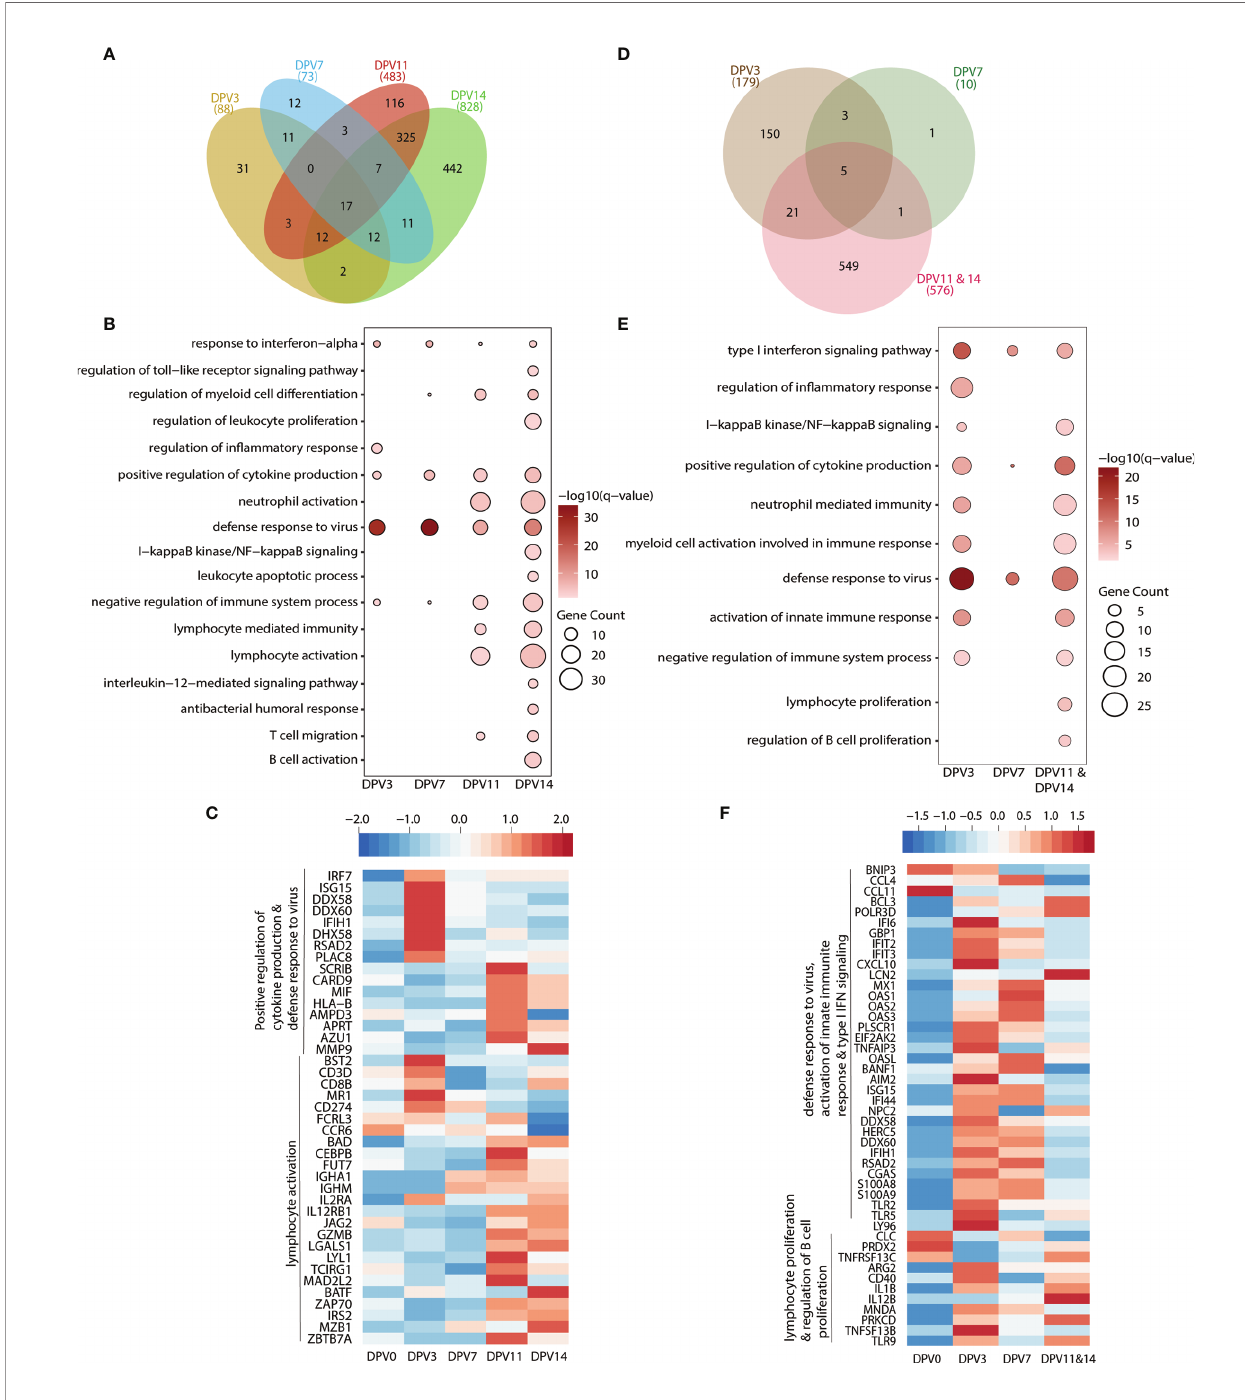
FIGURE 3 | VSV-MARV vaccination induces transcriptional changes indicative of antiviral defense and B cell activation. (A, D) Venn diagram of differentially expressed genes (DEGs) (DEGs, de fi ned as protein coding genes with human homologs with ≥ 2 fold change and false discovery rate (FDR) corrected p-value ≤ 0.05) detected in (A) VSV-MARV at 3 (n=8), 7 (n=8), 11 (n=4), and 14 (n=4) DPV relative to 0 DPV or VSV-EBOV at 3 (n=3), 7 (n=2), and 11/14 (n=2) DPV relative to 0 DPV. (B, E) Functional enrichment of DEGs detected 3, 7, 11, and 14 DPV; each bubble represents a Gene Ontology term; the size of each bubble represents number of DEGs enriching to that GO terms while color intensity represents the statistical signi fi cance (shown as – log 10 of the q-corrected p-value). (C, F) Heatmap of DEGs enriched to (C) “ positive regulation of cytokine production ” , “ defense response to virus ” and “ lymphocyte activation ” ; (F) “ defense response to virus ” , “ activation of innate immune response ” , “ type I interferon signaling pathway ” , “ lymphocyte proliferation ” , and “ regulation of B cell proliferation. ” Each column represents the median normalized transcript counts (RPKM) for each gene at each time point. The range of colors is based on scaled and centered RPKM values of the entire set of genes, with red indicating highly expressed genes and blue indicating lowly expressed